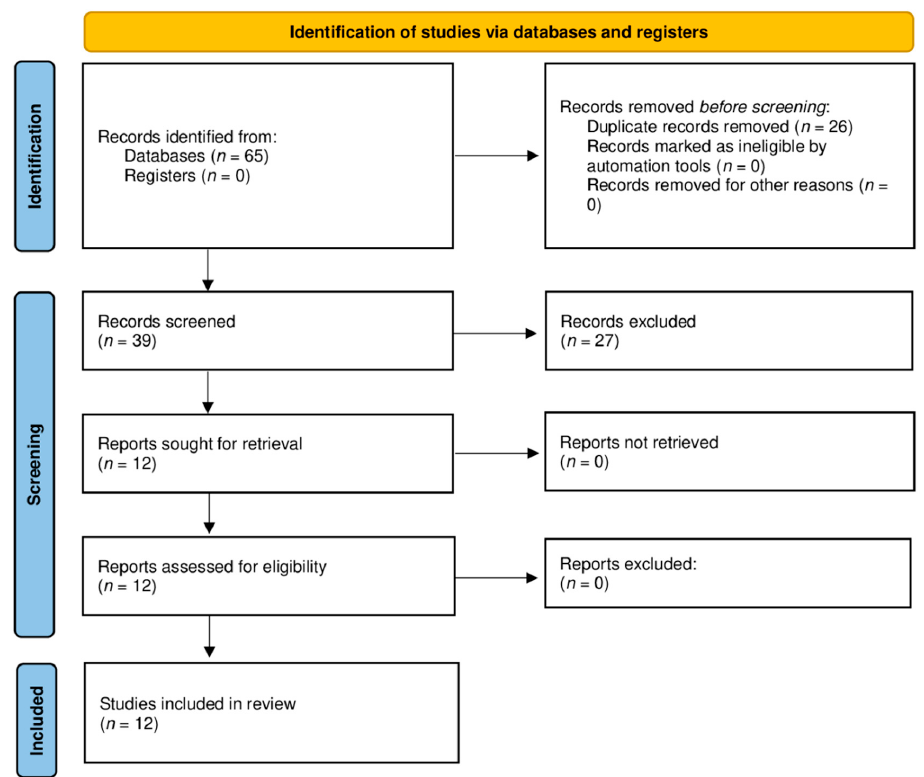
Figure 1. PRISMA 2020 flow diagram for new systematic reviews which include searches of databases and registers only. From: Page MJ, McKenzie JE, Bossuyt PM, Boutron I, Hoffmann TC, Mul- row CD, et al. The PRISMA 2020 statement: an updated guideline for reporting systematic reviews. BMJ 2021; 372: n71 [28].